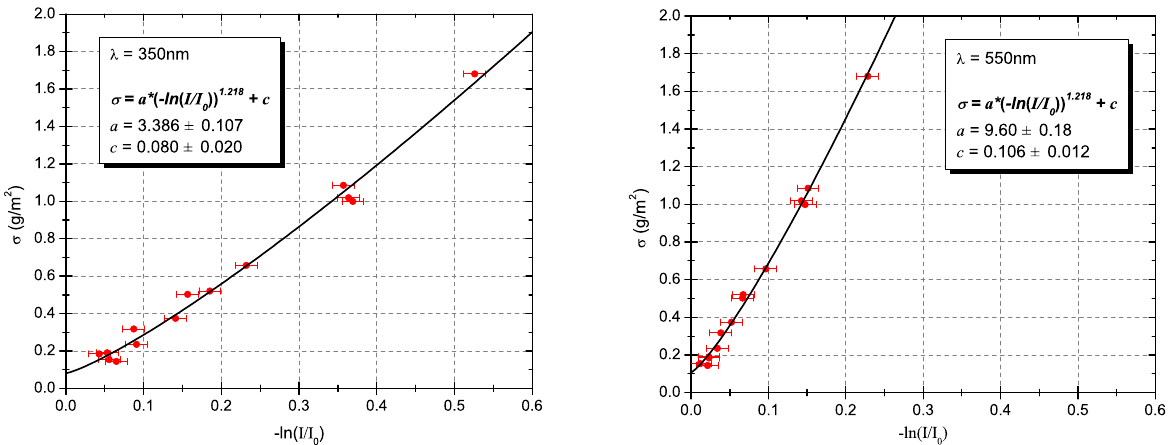
Figure 7. Power law fitting of the concentration σ in [ g m − 2 ] versus the logarithm of the reflectance ( I/I 0 ) using b = 1 . 218 and a and c as free parameters. These examples are for fine particles of the Eyjafjallajökull volcanic ash for two wavelengths: 350 nm and 550 nm . Error bars are the combined uncertainties of the reflectances and loaded mass of particles on the filters.